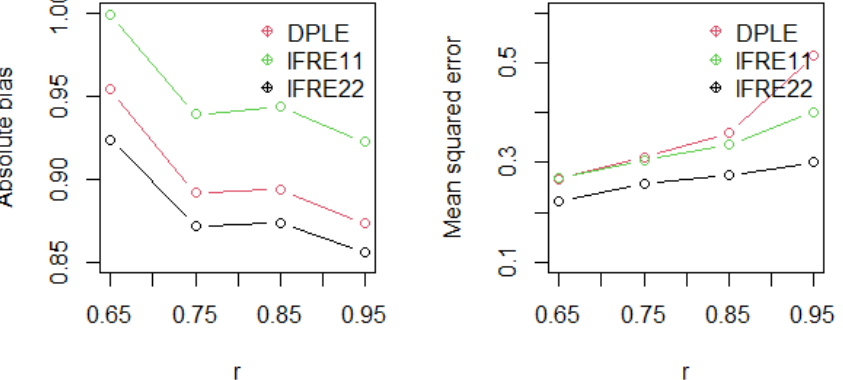
Figure 3. Plots of the bias and MSE for four different scenarios which combine a fixed sample size n = 80 with a variational correlation coefficient obtained by DPLE, lFRE11 and